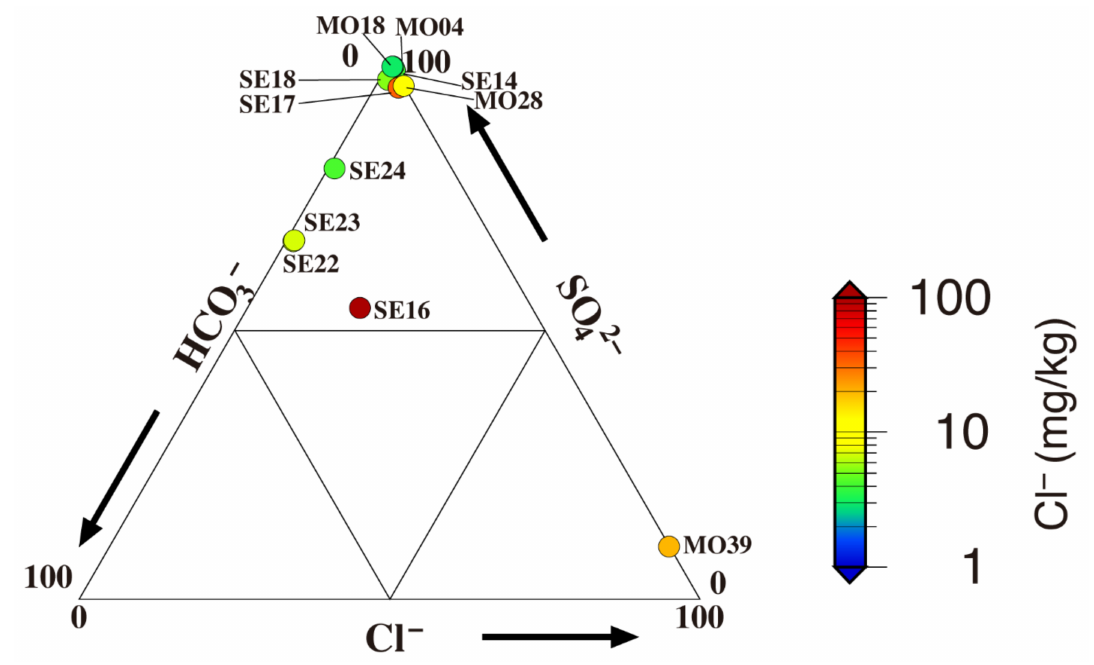
Figure 13. Triangular plot of major anions in hot spring water from wells to the west of Owakudani. The numbers in the triangular plot indicate the composition (%) of each ion. The colored circles show the chloride ion content in the hot spring water. The numbers of the hot spring wells and their locations are shown in Figure